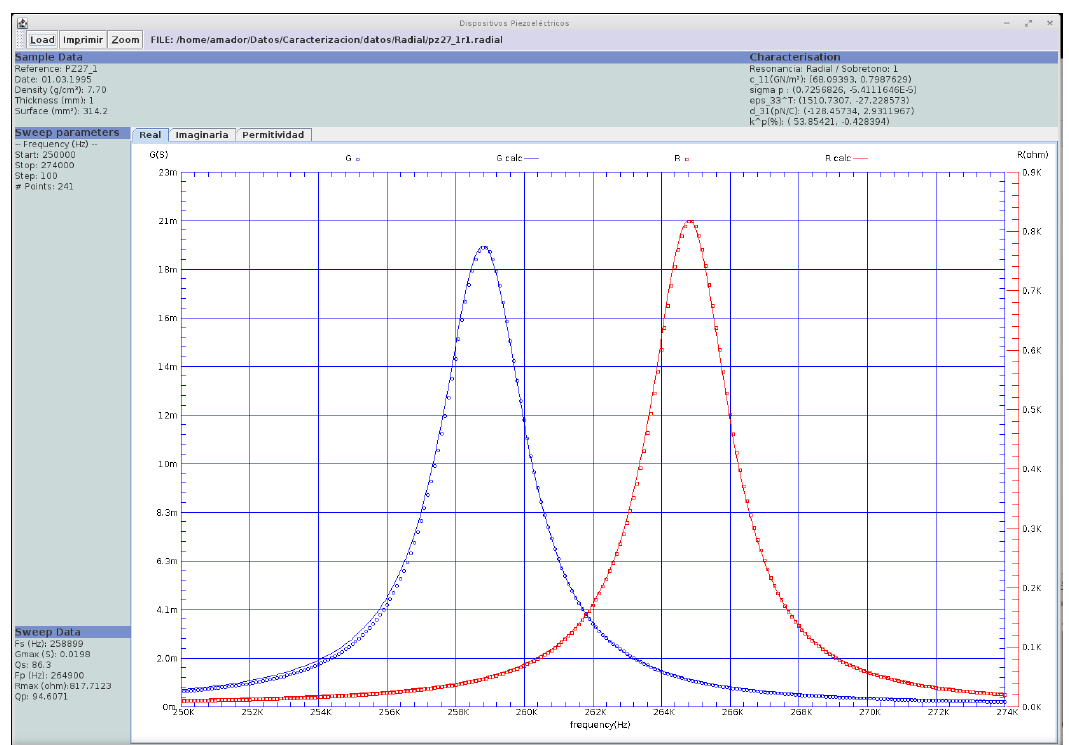
Figure 4. Presentation of the results obtained using Alemany’s method for measurement at the first overtone of the radial resonance mode of a PZ27 (Ferroperm Piezoceramics A/S) thin disc.